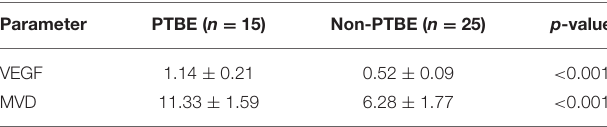
TABLE 2 | Comparison of VEGF and MVD in the two